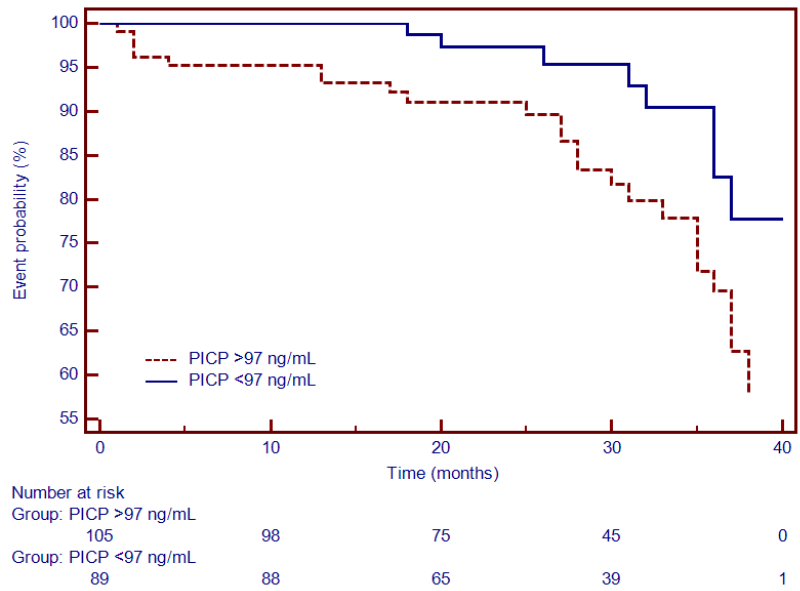
Figure 5. Kaplan–Meier analysis for the ability of PICP to predict cardiovascular outcome. Abbrevia- tions: PICP, procollagen type I carboxy-terminal pro-peptide.